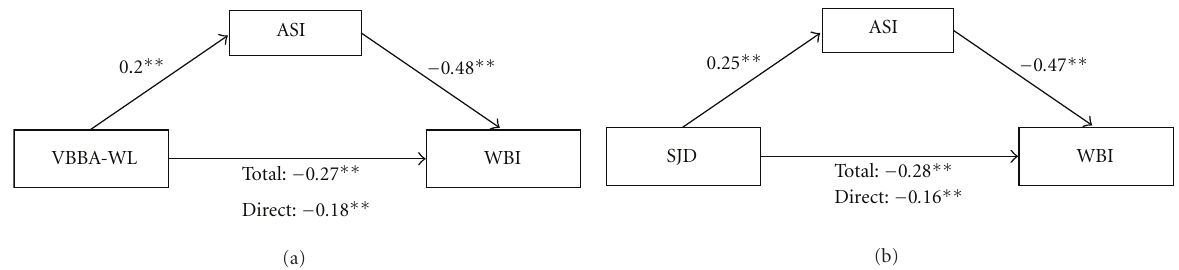
Figure 1: Path models for subjective well-being. Note. VBBA-WL: workload, SJD: specific job demands, ASI: Insomnia, WBI: well-being Index.